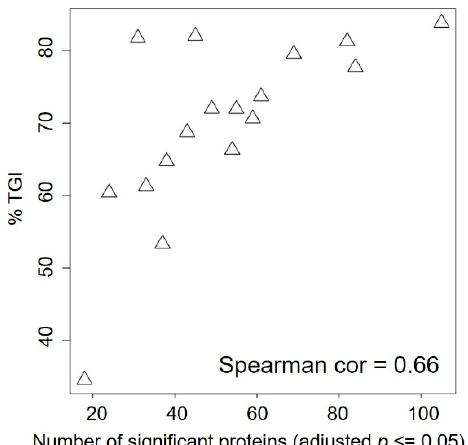
Figure 4. Scatter plot correlating %TGI with the number of significantly changed proteins comparing BKM120 vs. vehicle therapy.